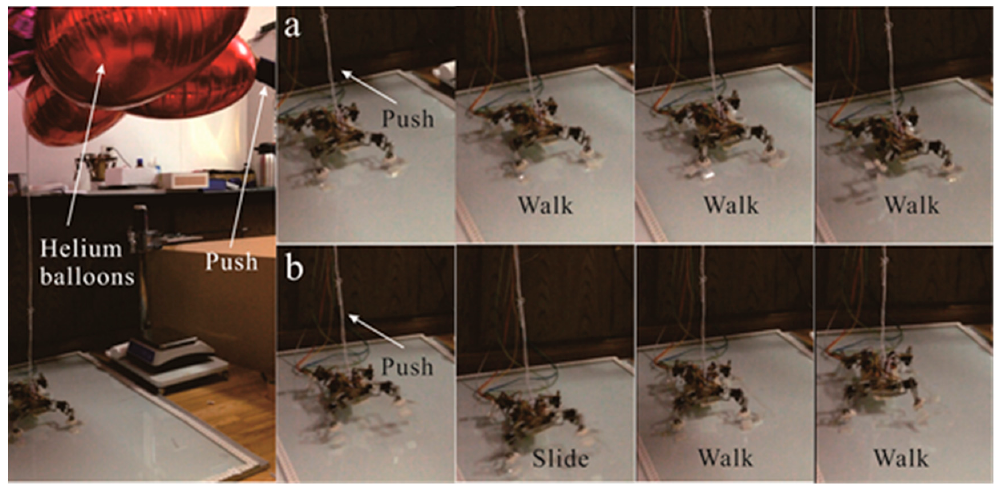
Figure 8. Robot climbing on glass surface with lateral impact at a RRG of 94%.